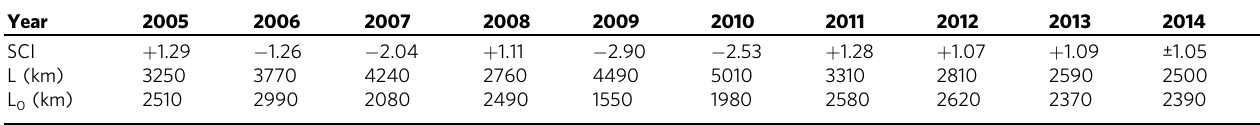
Table 1 For each year, the Separatrix Curvature Index (SCI), de fi ned as the ratio of the length of the streamline from the source of the separatrix to its terminus (L), to the length of the corresponding great circle arc, joining source and terminus (L 0